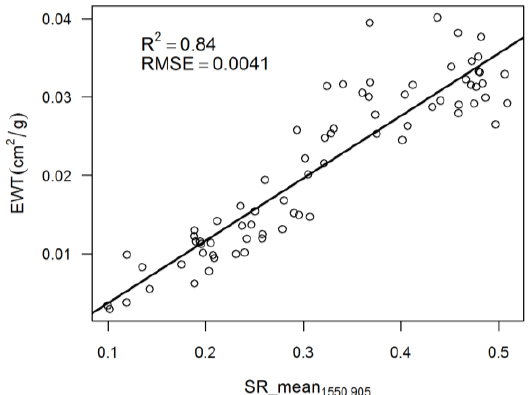
Figure 2. Relationship between the best explanatory laser intensity variable and equivalent water thickness